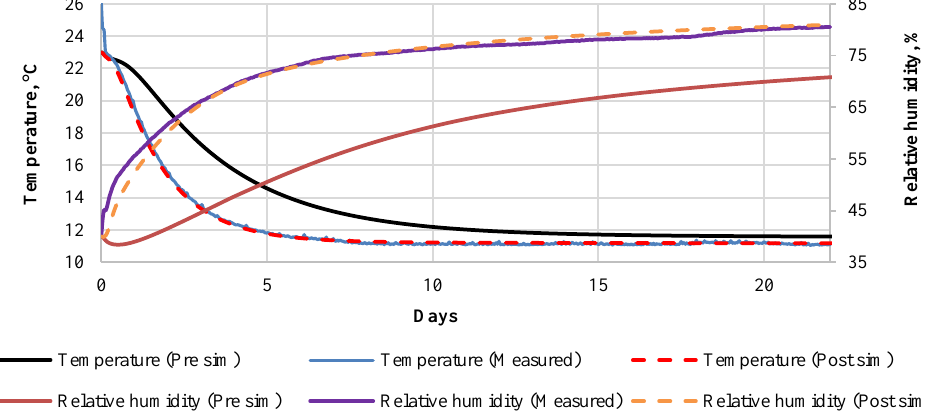
Fig. 9. Behaviour of temperature and relative humidity between masonry and wood fiber without vapour barrier insulation layer: simulation before and after experiment, and measured